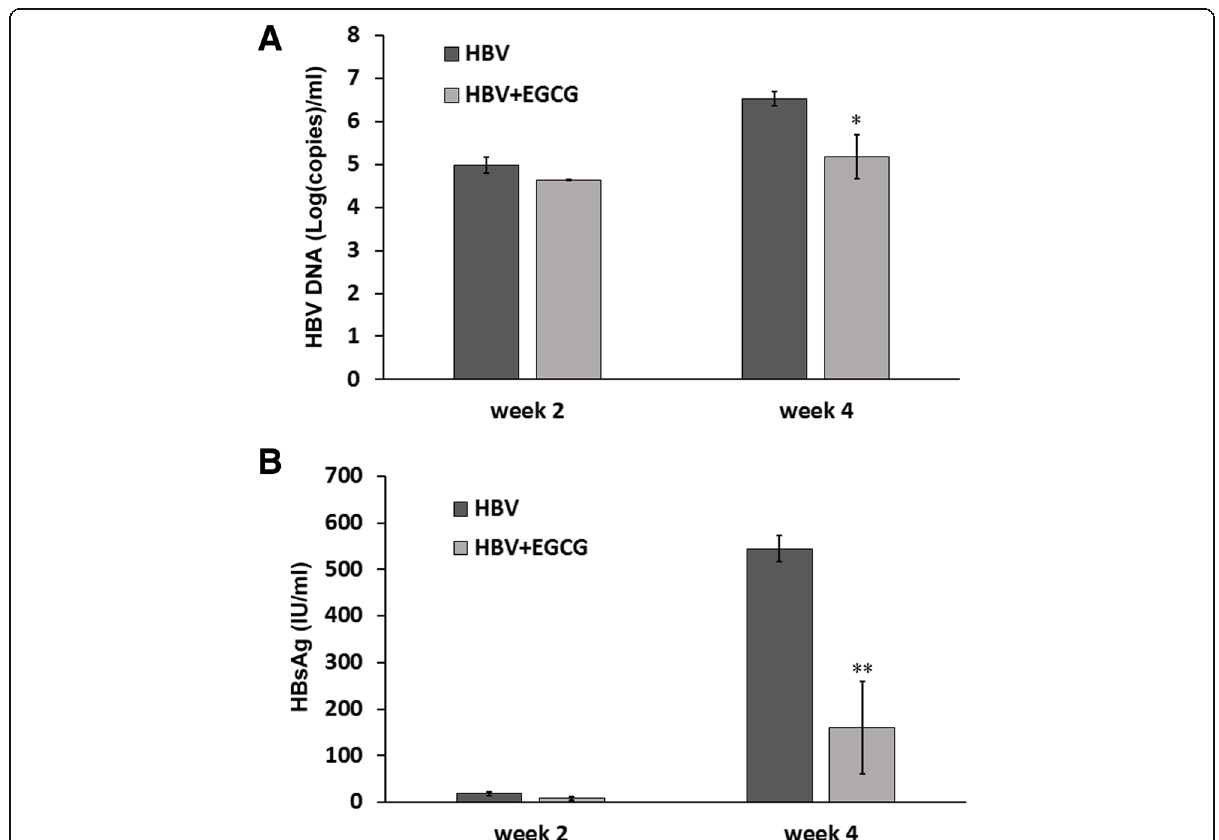
Fig. 4 HBV titers in Hu-FRG mice. HBV titers were determined as HBV DNA copies ( a ), and HBV HBsAg expression levels ( b ). The data are expressed with mean±SEM and were analyzed by student t-test (HBV, n=3; HBV+EGCG, n=3; * p <0.05, ** p <0.01).